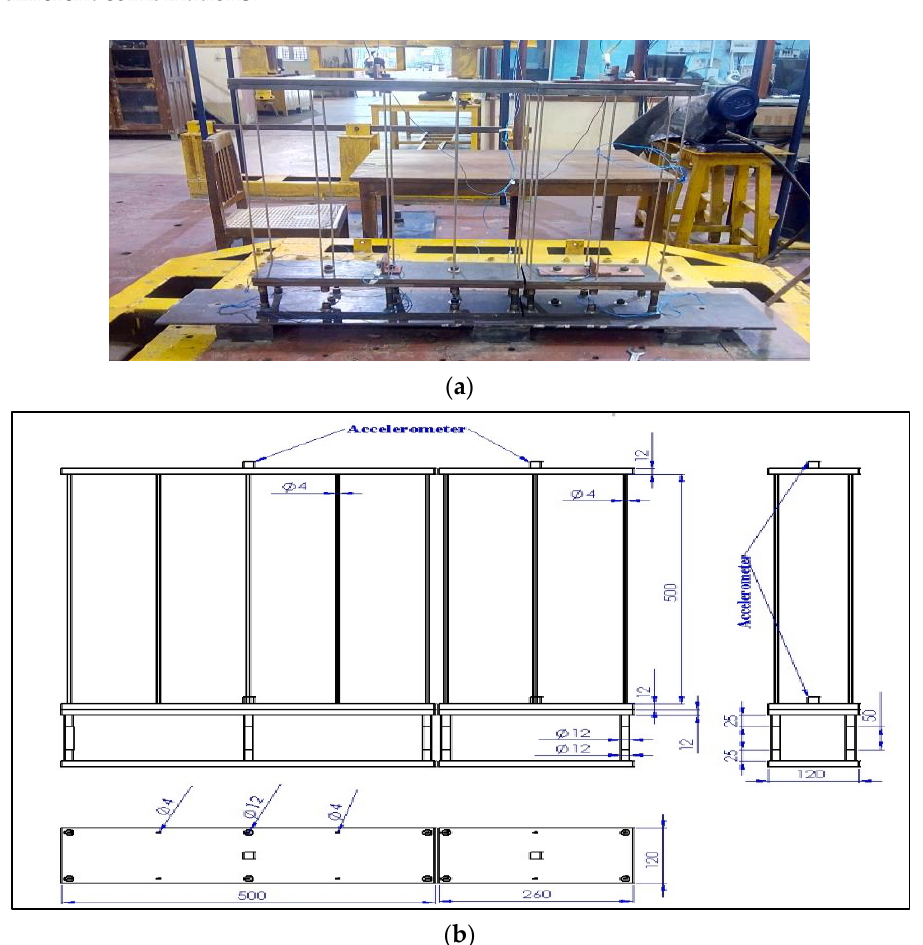
Figure 3. Base-isolated flexible models. ( a ) Experimental setup; ( b ) schematic diagram.